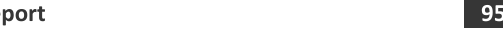
Case Report Acute myeloid leukaemia with myelodysplasia-related change in a child living with human immunodeficiency virus infection, a transformation from underlying juvenile myelomonocytic